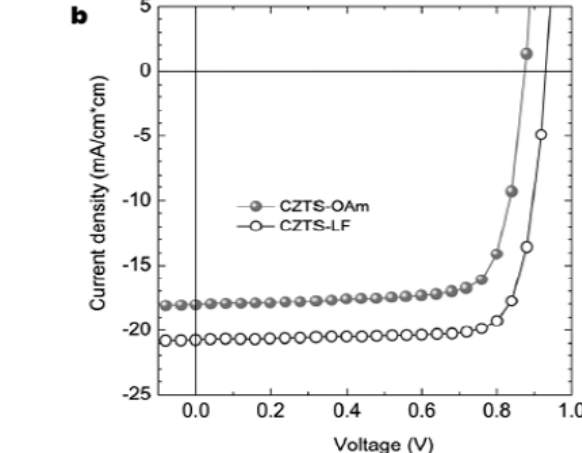
NH PbI /PCBM /Ag) using CZTS as HTM: (a) 3 3 3